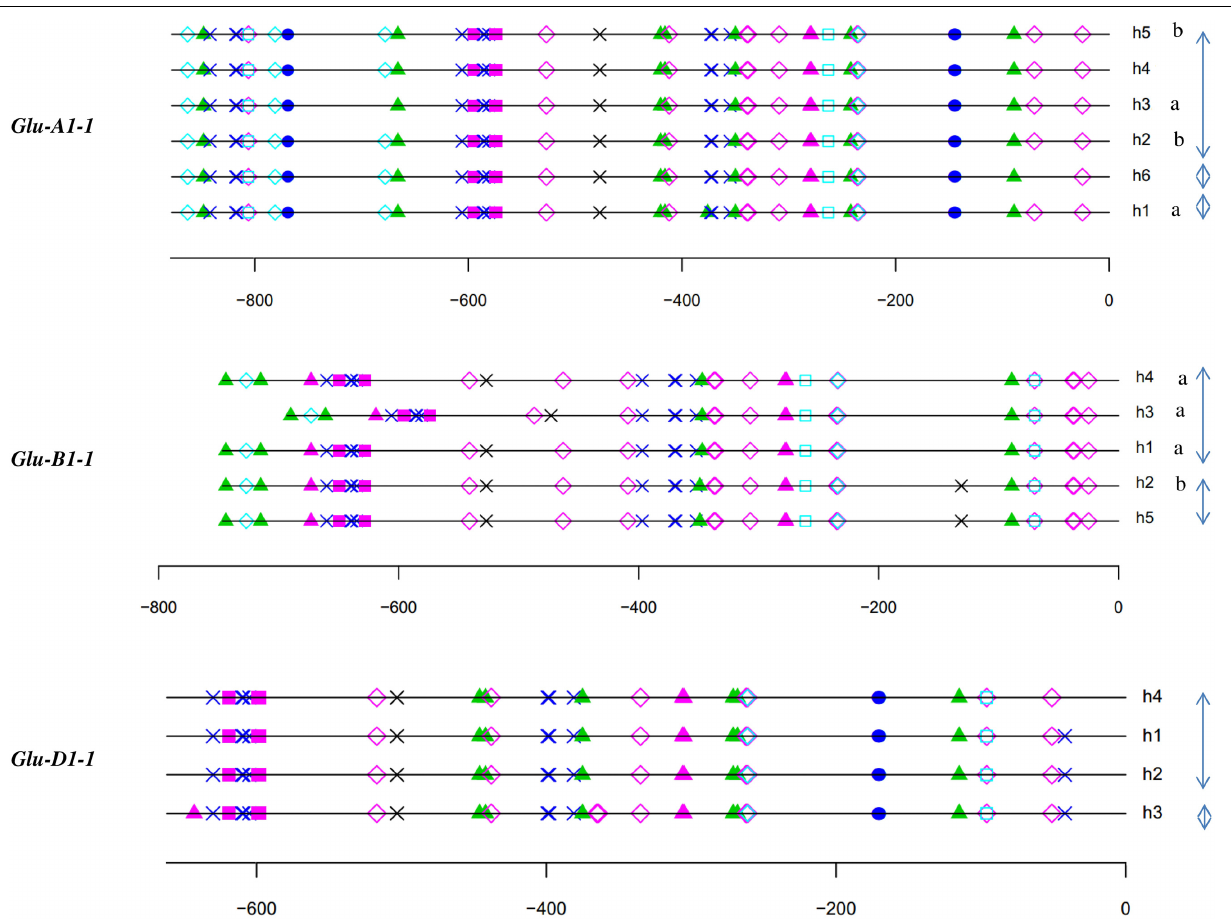
by the number of the haplotype. Letters a and b indicate the significantly different groups for the mean of expression for haplotypes studied by qRT-PCR. Clusters of haplotypes differing by one polymorphism are shown with gray arrows on the right. See the key to Figure 2 for descriptions of cis -motif